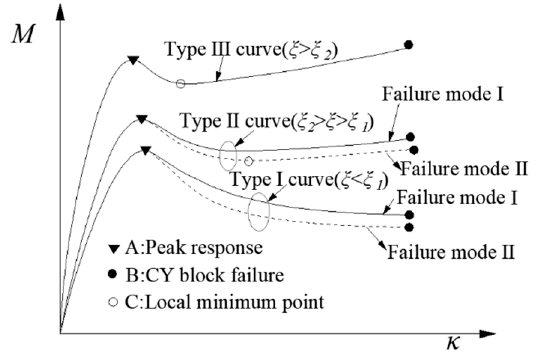
Figure 3. Moment–curvature responses.